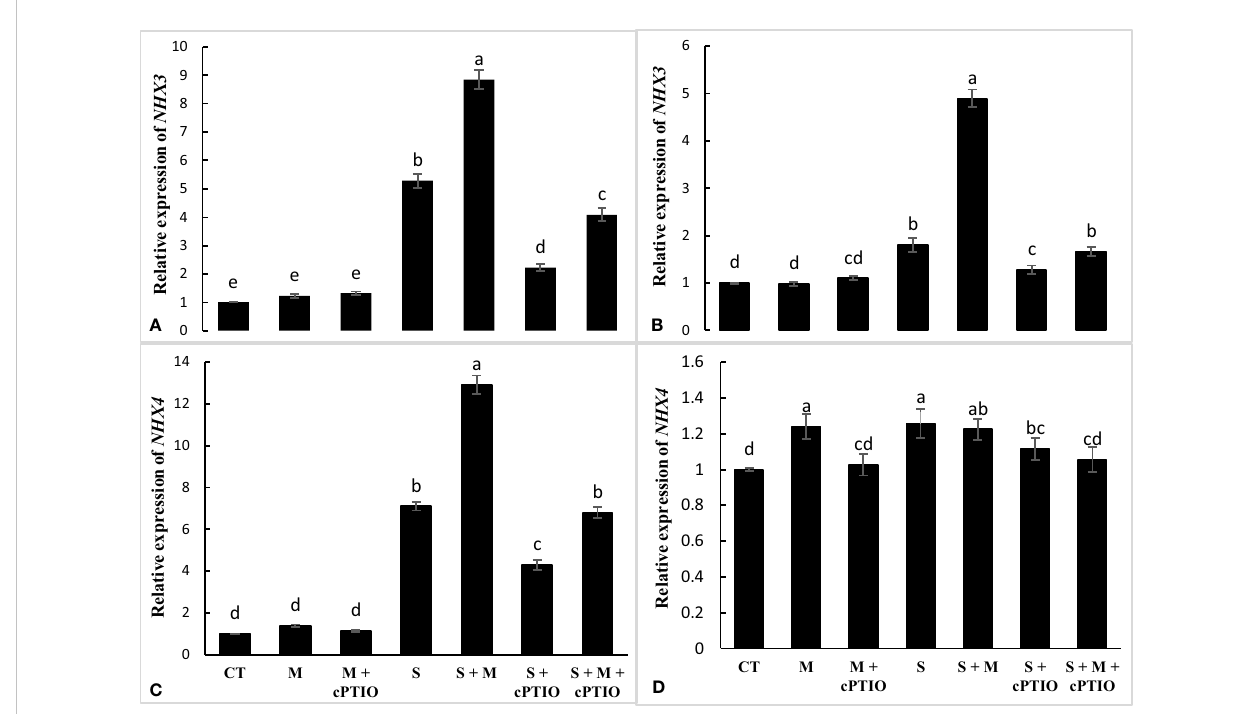
FIGURE 6 The relative expression of NHX3 and NHX4 genes in the root (A, C) and leaf (B, D) of tomato seedlings treated with melatonin (150 m M) and cPTIO (100 m M) under NaCl (150 mM) treatment. Different letters in each column show signi fi cant differences at the p < 0.05 based on the LSD test (means ± SD, n = 3), CT, control treatment; M, melatonin; S,